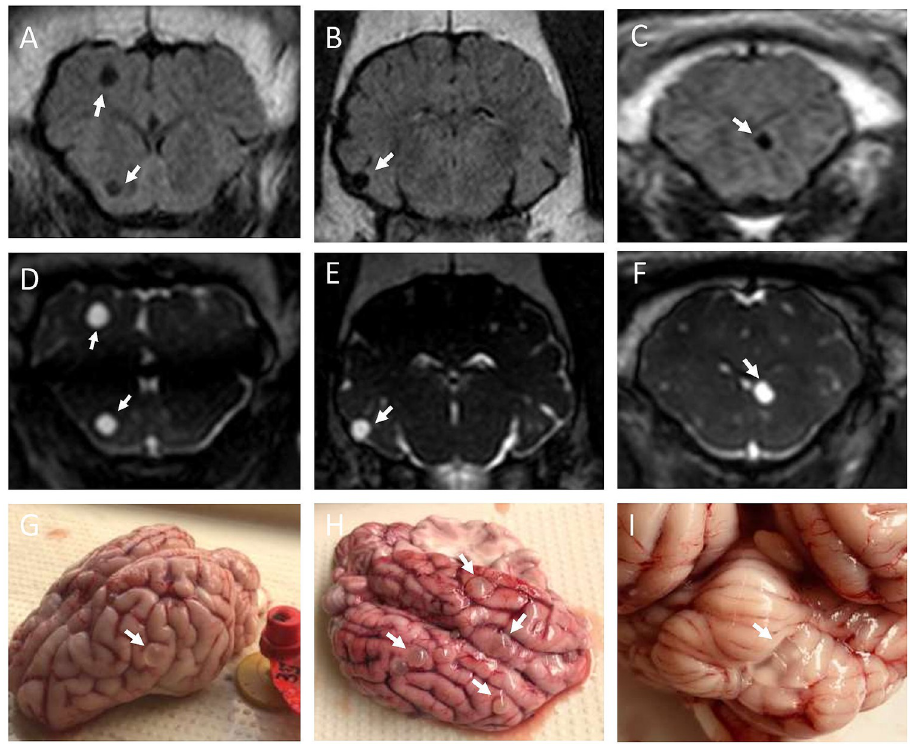
Fig 1. Brain MRI findings and gross examination of pigs’ brains showing cysticerci (white arrows). (A-C) Fluid- attenuated inversion recovery (FLAIR) sequences; (D-F) Fast imaging employing steady-state acquisition (FIESTA) sequences; (G-H) Corticomeningeal cysticerci; (I) Cysticerci lodged in the cerebellum.